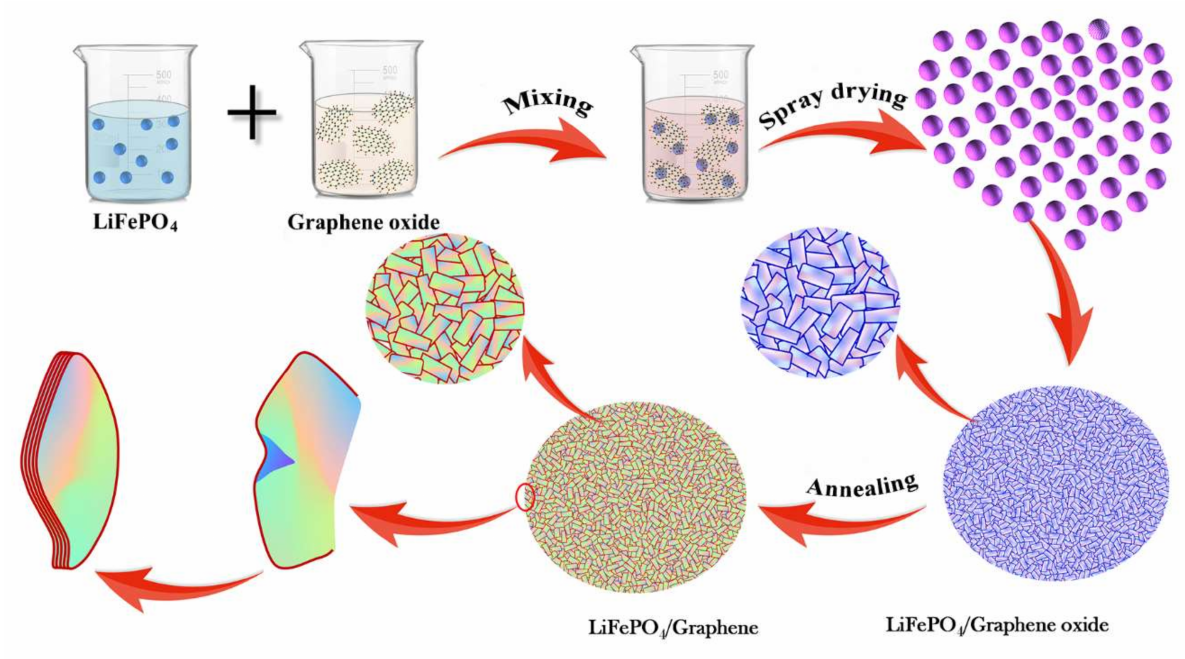
Figure 24. Schematic illustration of the synthesis of rGO modified LiFePO 4 . Adapted and reproduced with permission from Ref. [108]. Copyright 2011 Royal Society of